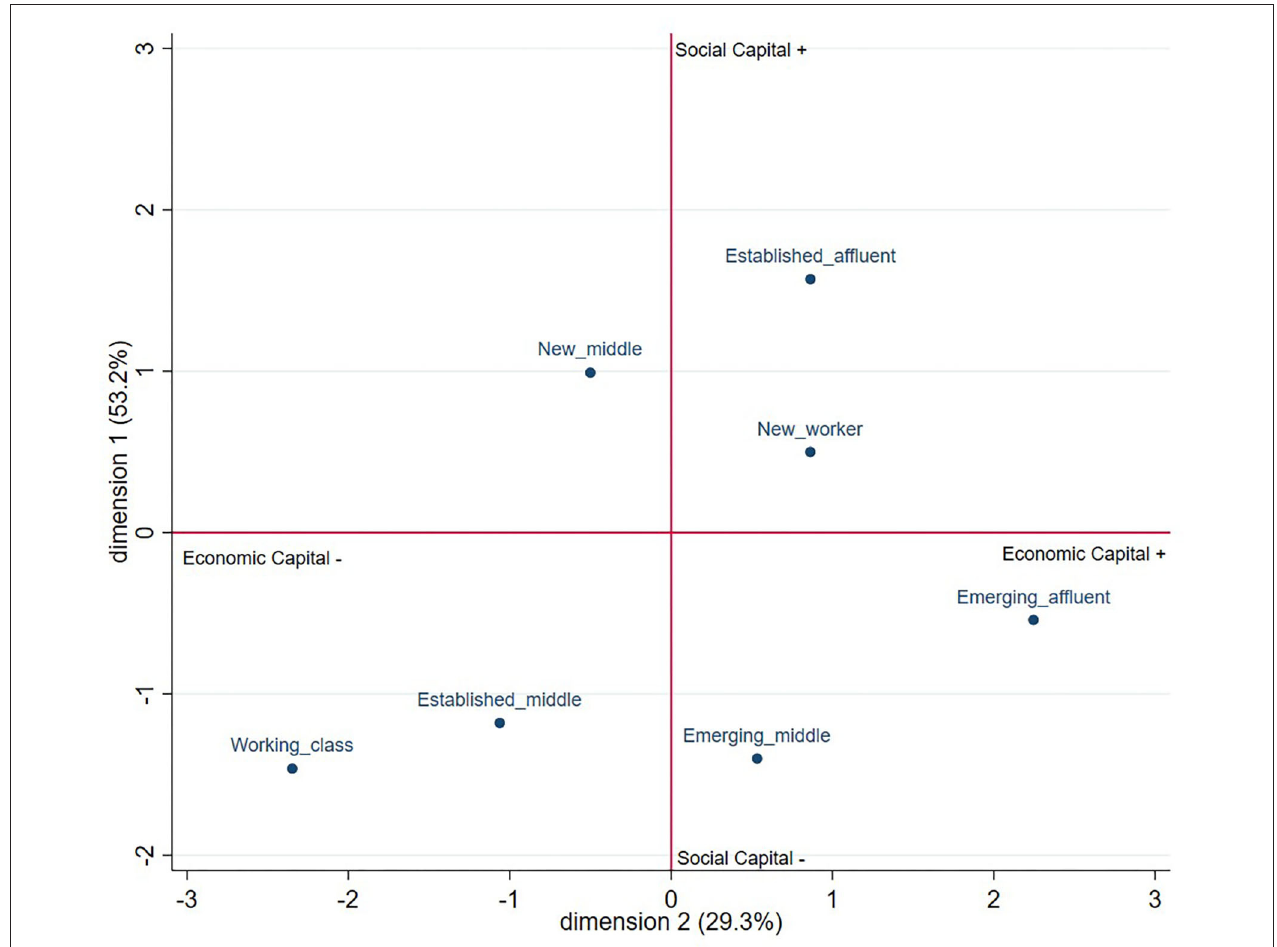
FIGURE 1 | The position of social classes in social space by economic and social